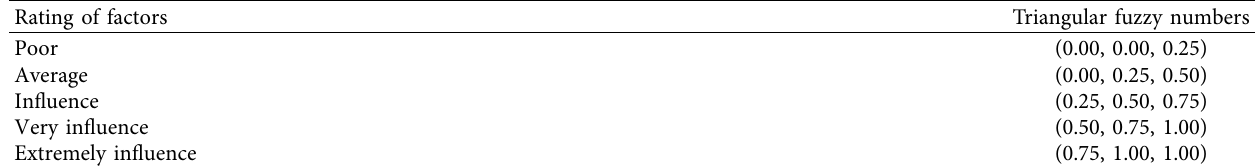
Table 2: Linguistic variable “influence” and corresponding fuzzy numbers.